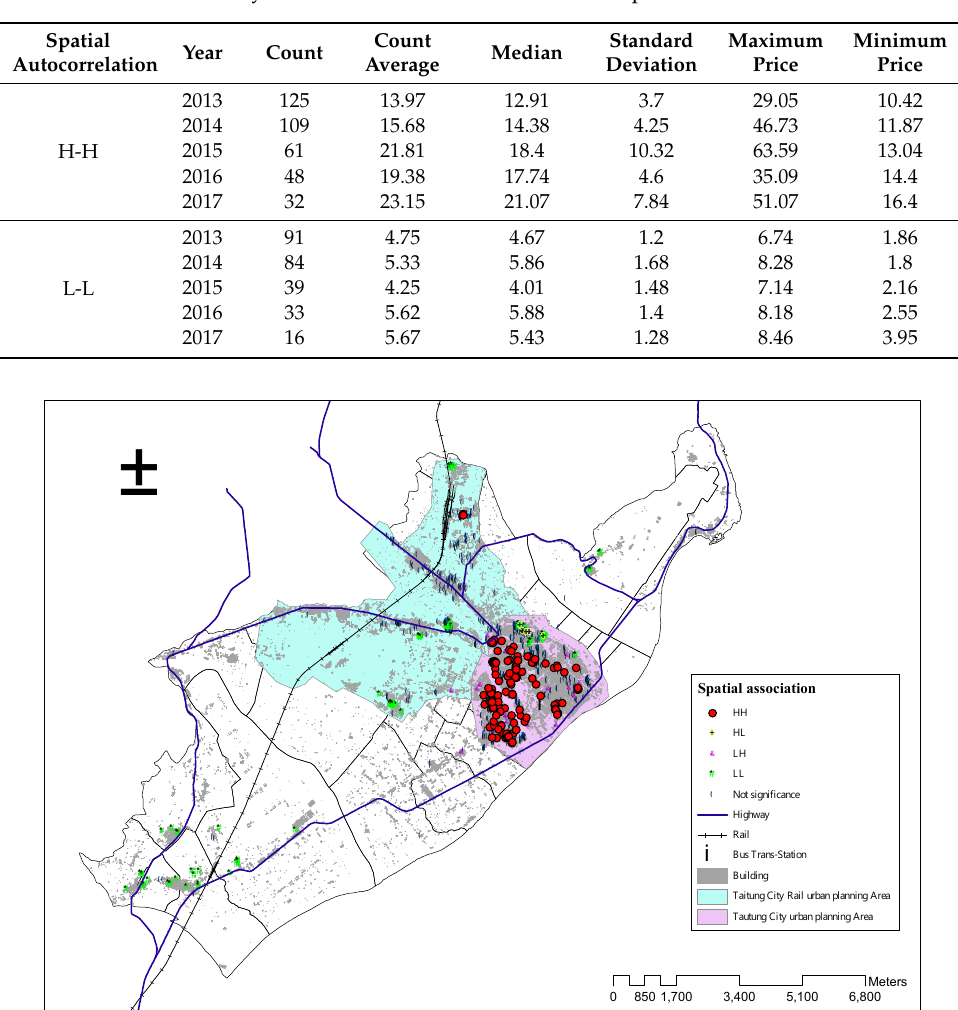
Table 5. Yearly narrative statistics of real estate unit price of H-H and L-L.